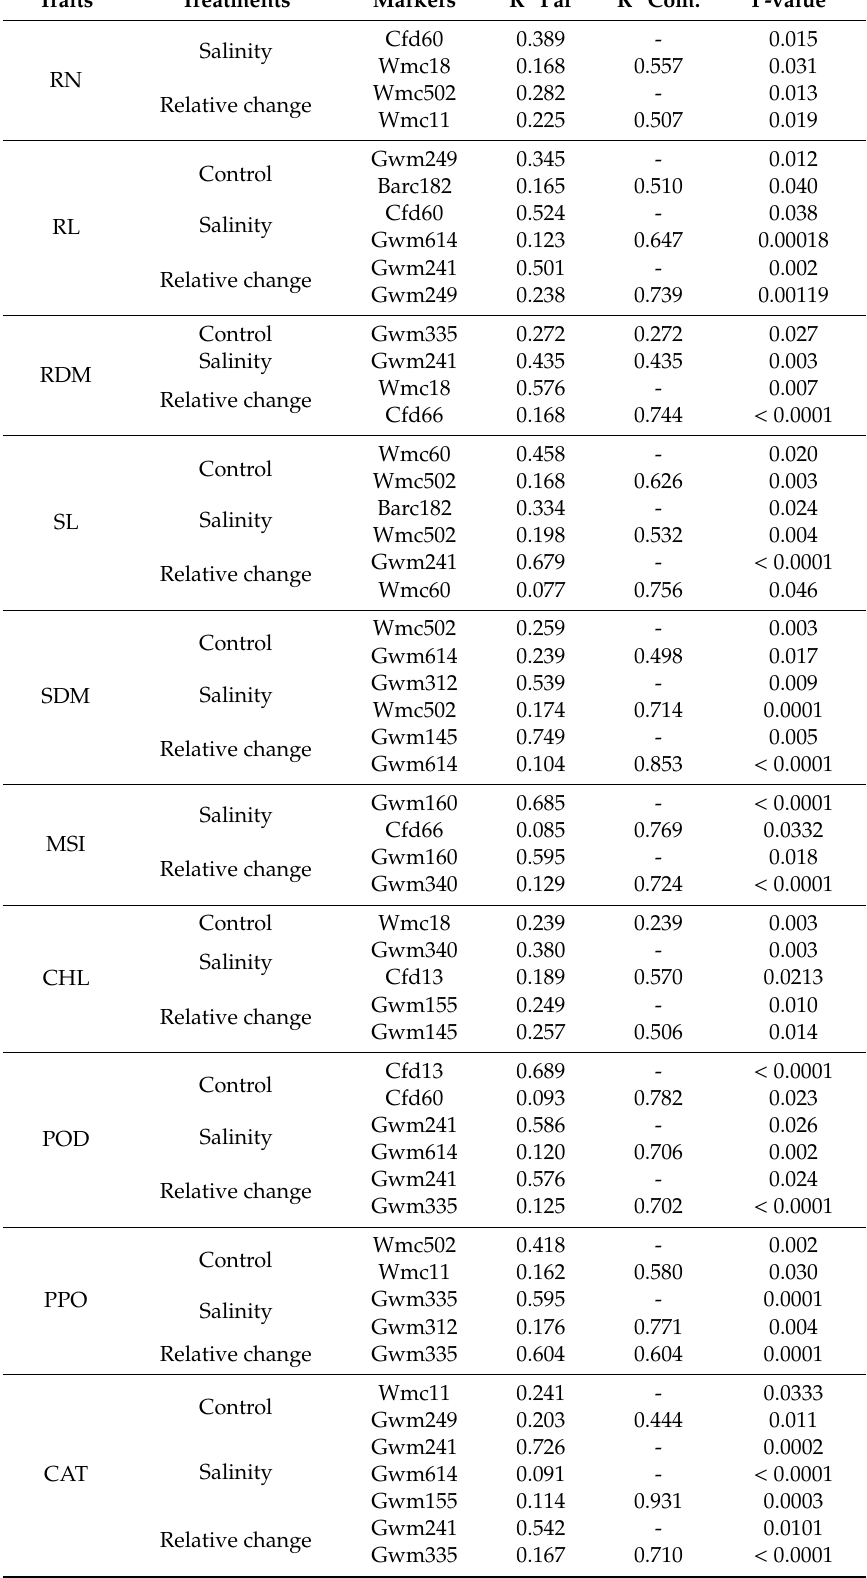
Table 7. Selection of the influential markers (independent variables) with 13 studied traits (dependent variable) for both treatments of control and salinity and relative change based on stepwise multiple linear regression (SMLR)